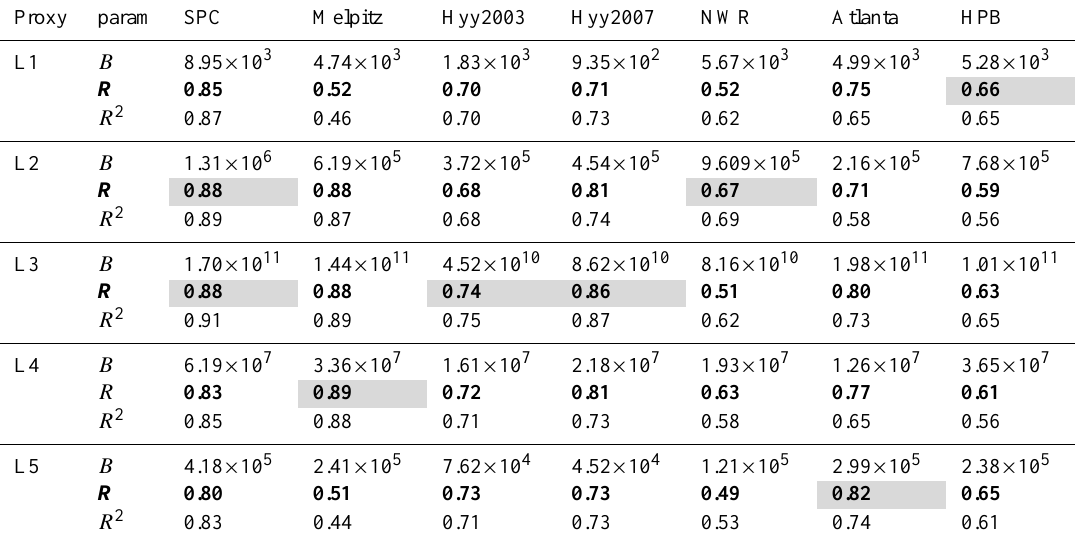
Table 4. Linear fit with fixed parameters. B is the slope of the proxy, R is the correlation between observed [H 2 SO 4 ] and the predicted values given by the proxy and R 2 is the coefficient of determination calculated from the sums of squares in the linear fit procedure. Best correlations for each site are highlighted.